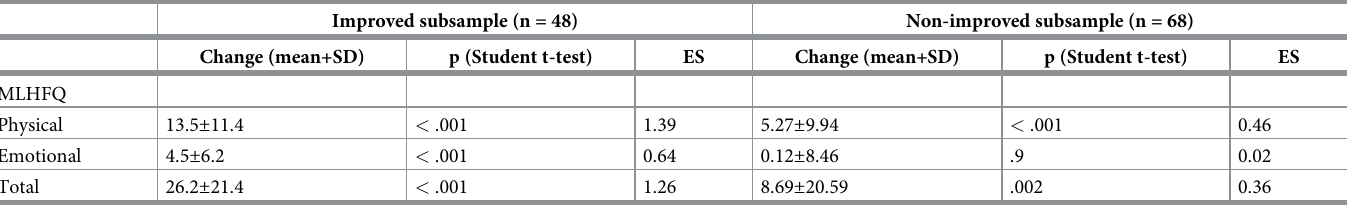
Table 5. Sensitivity-to-change estimators for the clinically improved and clinically non-improved subsamples for the MLHFQ, EHFScB and PELC instruments.